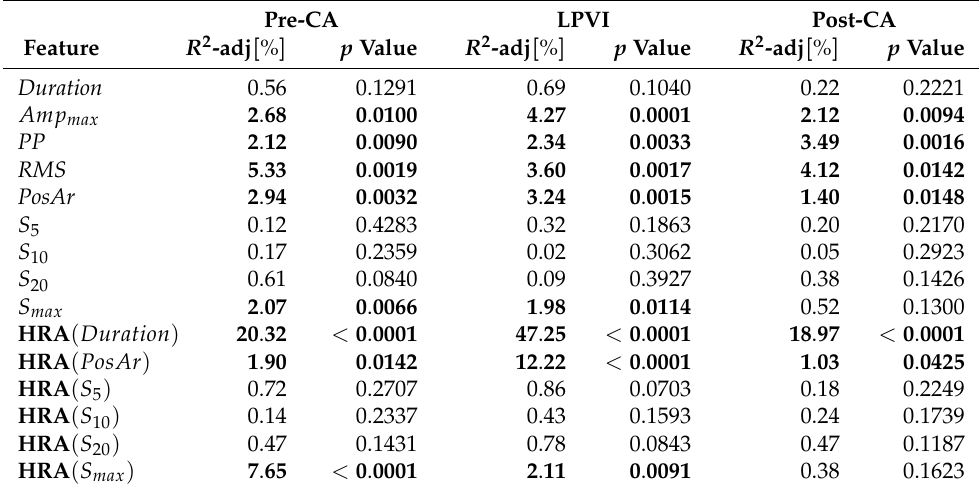
Table 2. Linear regression analysis results between surface and invasive features for each and every activation. Statistically significant results are shown in bold .